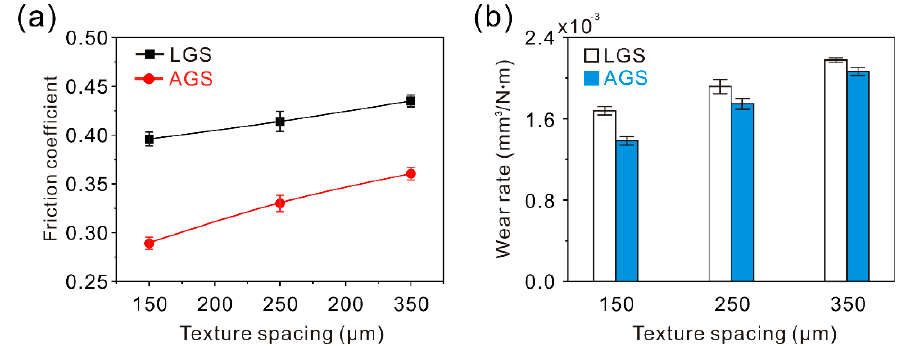
Figure 17. ( a ) Friction coefficient and ( b ) wear rate of the LGS and AGS with different texture spacings (load of 0.3 N, sliding speed of 100 mm/s, frictional pair of GCr15 bearing steel, friction time of 10 min). The friction coefficient and wear rate of the micro-scale structure surface samples with